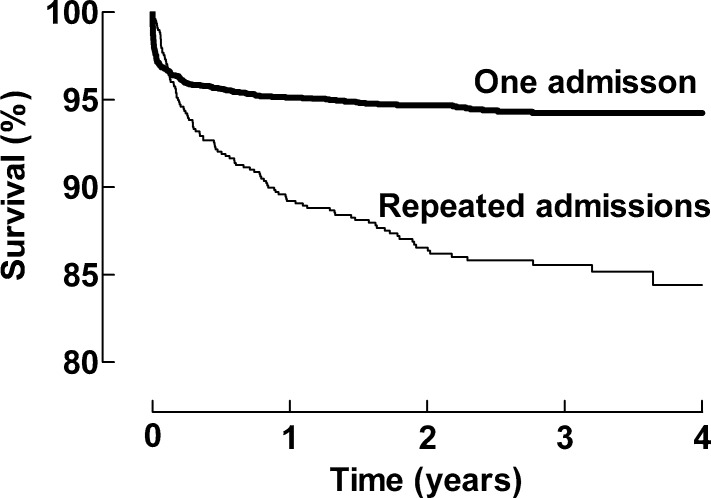
Cumulative survival for the single and multiple admission groups.Statistically significant differences between curves are as follows: Hazard Ratio 3.28; 95% CI 2.43–4.44, Log-rank (Mantel-Cox) or Gehan-Breslow-Wilcoxon Test, both p<0.0001.